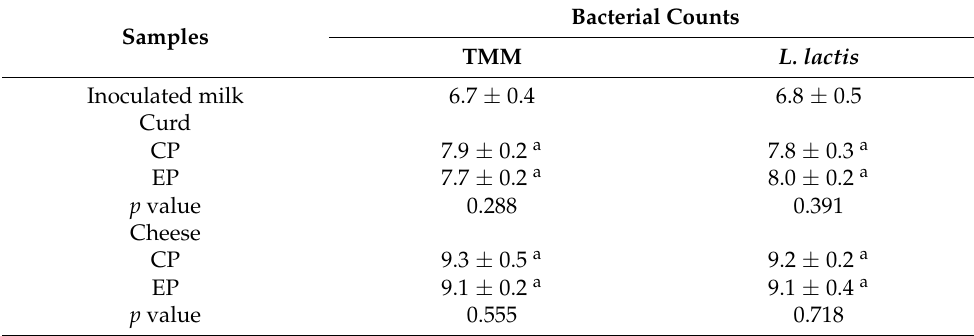
Table 1. Growth of commercial starter LAB during cheese production.